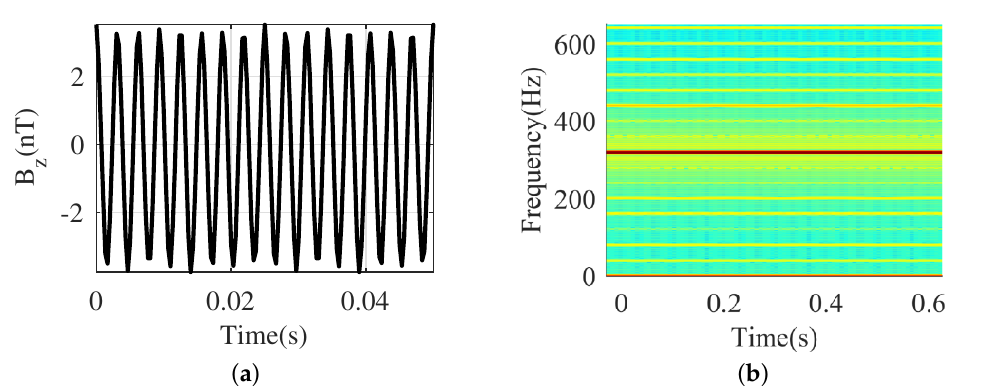
Figure 2. ( a ) Field at the point 3 m away from the shutter antenna. ( b ) Spectrogram of field.